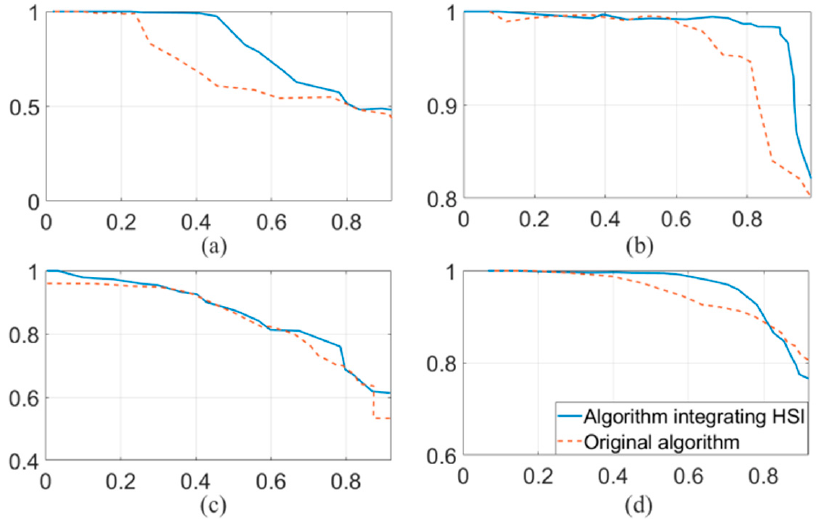
Figure 16. ( a – d ) are precision–recall curves of the four experiments,